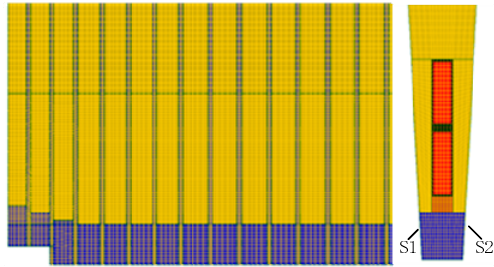
Table 2. Statistical results of the number of nodes and memory.